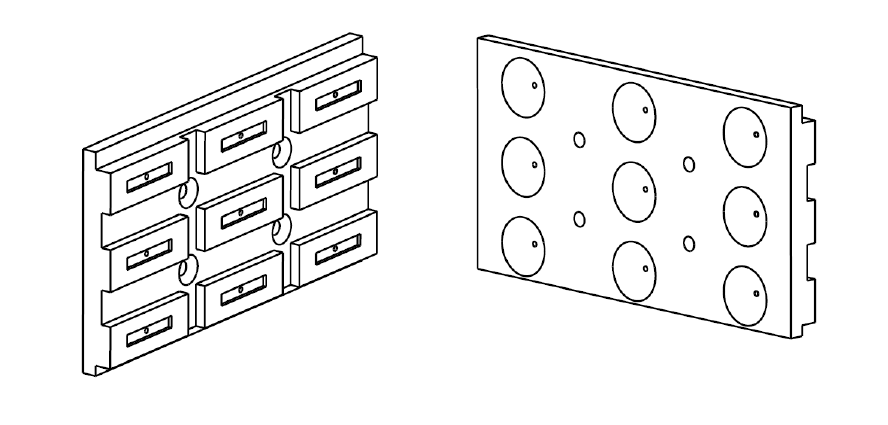
Figure 6. Design of the nozzle plate of the hydrostatic guides.